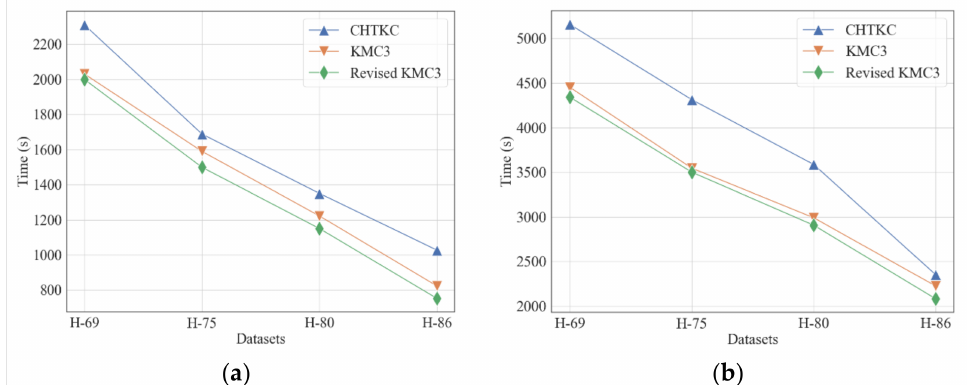
Figure 11. Comparison of the dumper of KMC3, CHTKC, and Revised KMC3 with various sequenc- ing data. ( a ) k = 32; ( b ) k =